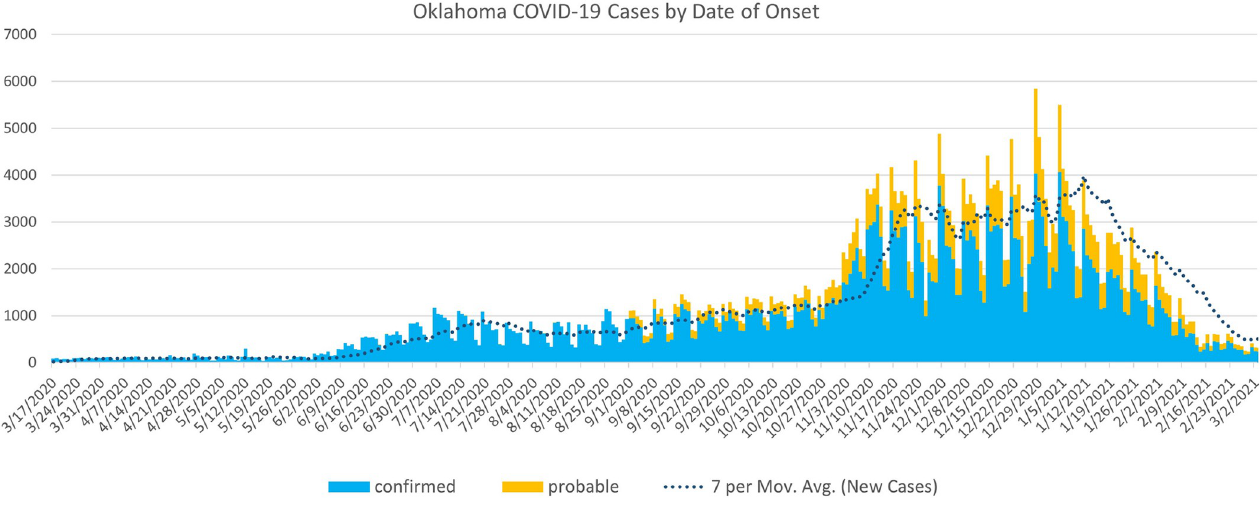
Fig 3. Daily case numbers and 7 day average of cases for the state of Oklahoma. Source: OSDH Weekly Epidemiology and Surveillance Report.